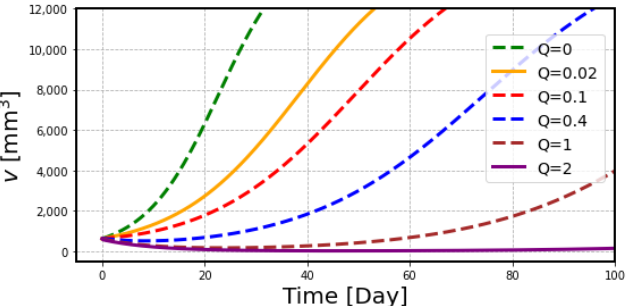
Figure 7. Calculated dose-response curves to predict the tumor response to 211 At treatment. Two conditions, 0.02 MBq ( Q = 0.02) in yellow and 2 MBq ( Q = 2) in purple, are shown as additional curve lines for the results in Figure 6.